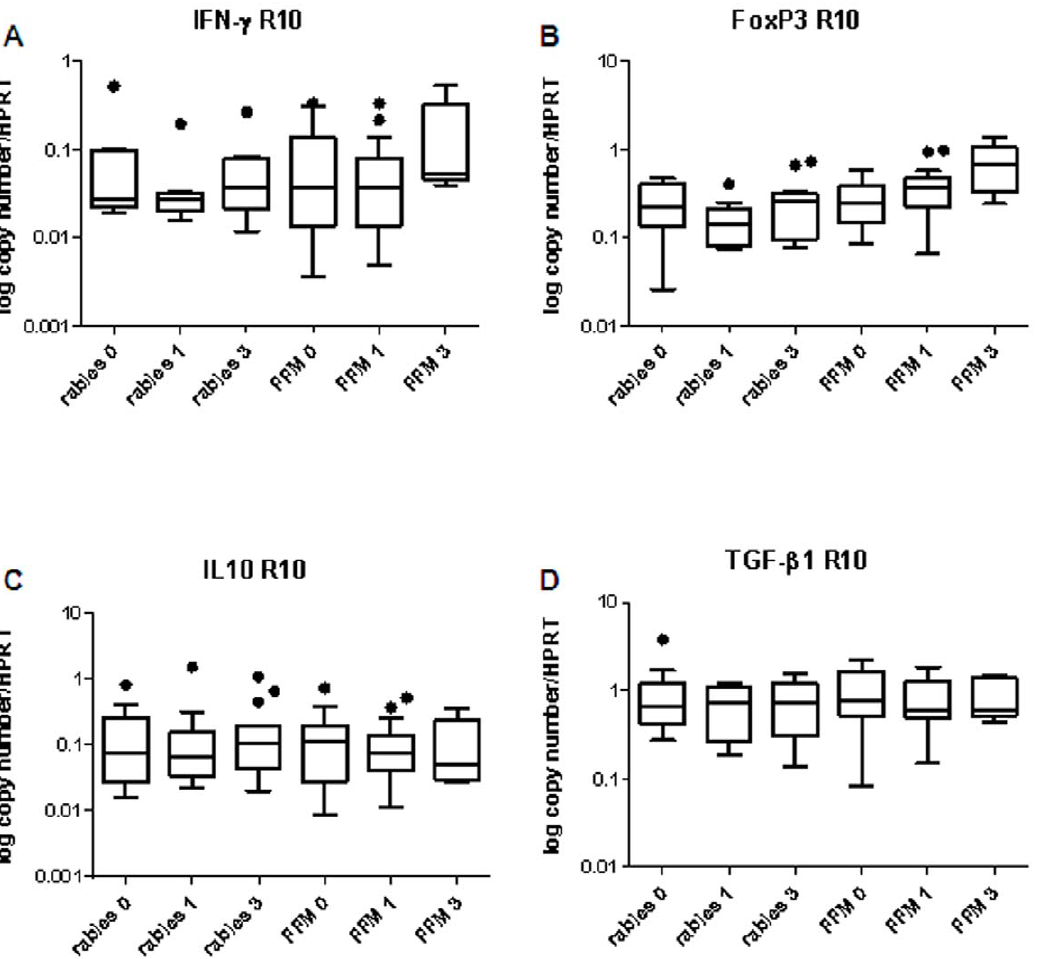
Figure 5. FoxP3 mRNA expression increases over the 3 month study period in media-stimulated cells from subjects in the FFM ME-TRAP vaccine group. A) IFN- c mRNA expression B) FoxP3 mRNA expression C) IL10 mRNA expression D) TGF- b 1 mRNA expression (n = 10–20).